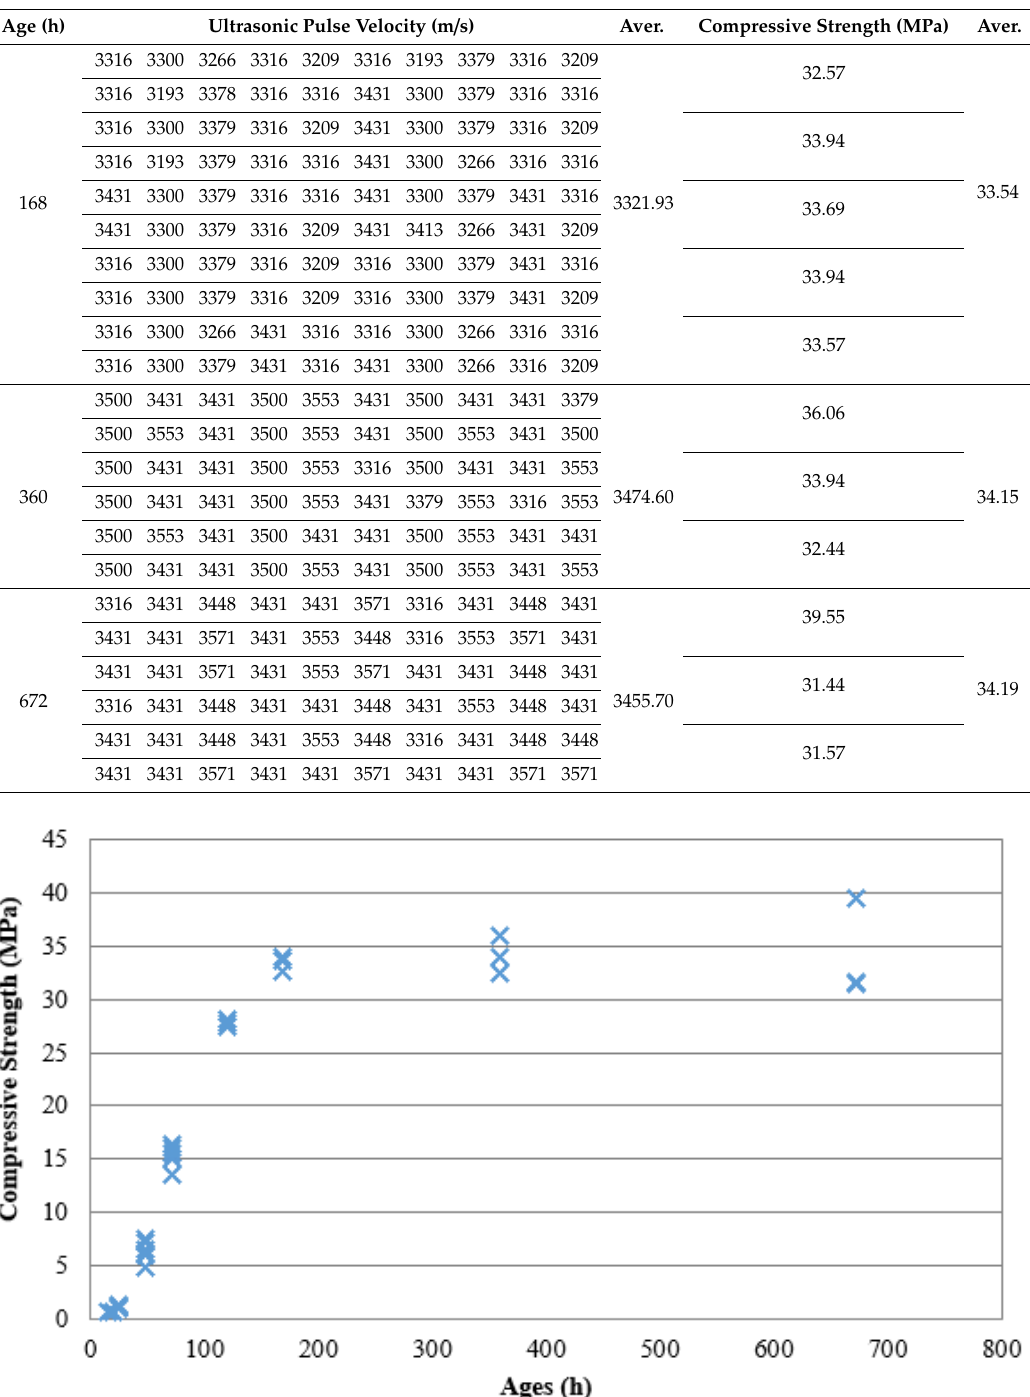
Figure 11. Compressive strength with age (40 MPa).